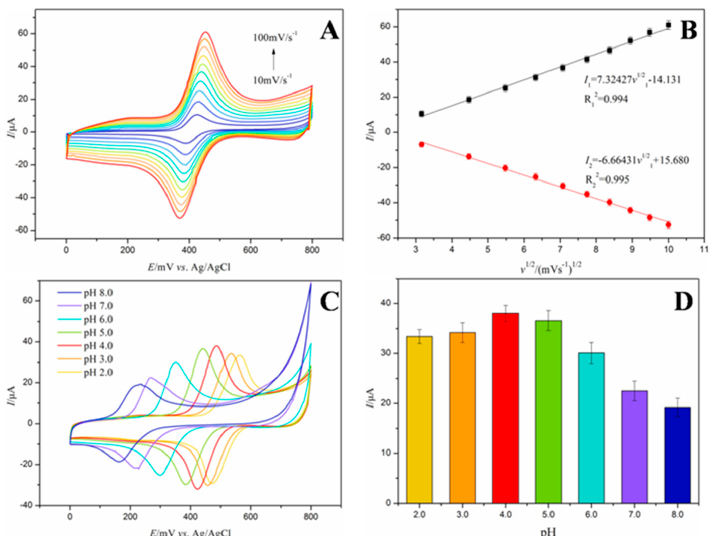
Figure 5. ( A ) Cyclic voltammograms of the Zn–PPIX–CS–MWCNTs/GCE toward 0.5 mM caffeic acid in 0.05 M Na 2 HPO 4 –citric-acid solution (pH 4.0) with different scanning rates. ( B ) Linear rela-